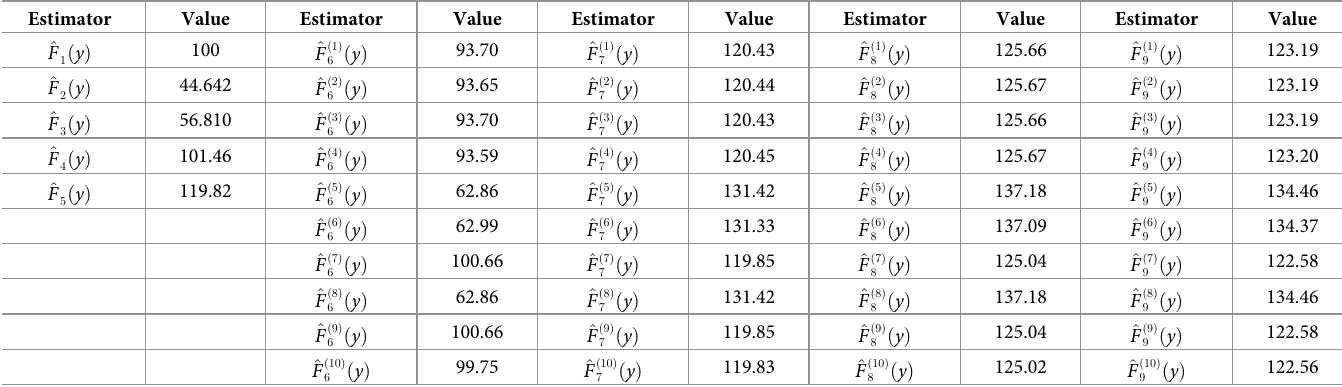
Table 4. PREs of distribution function estimators using Population II. Estimator